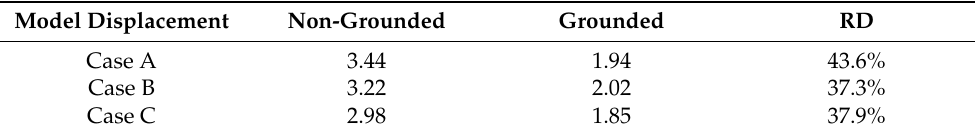
Table 3. Maximum induced electric field strength (V/m). RD refers to relative difference.